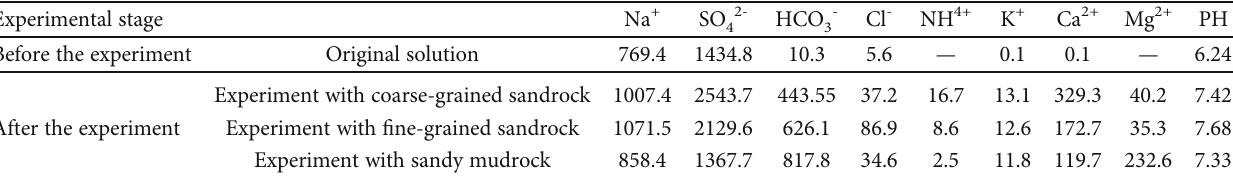
Table 2: Contents (mg/L) of major ions and pH values of the water solution before and after the experiment. Experimental stage Before the experiment